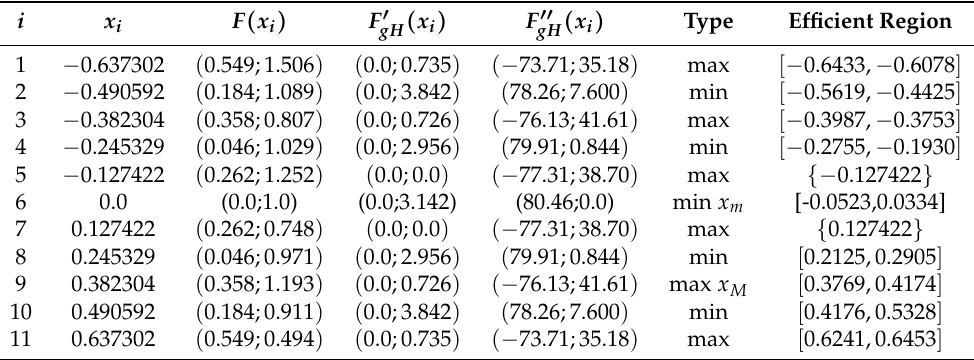
Table 1. Relevant points of F ( x ) in the Complete